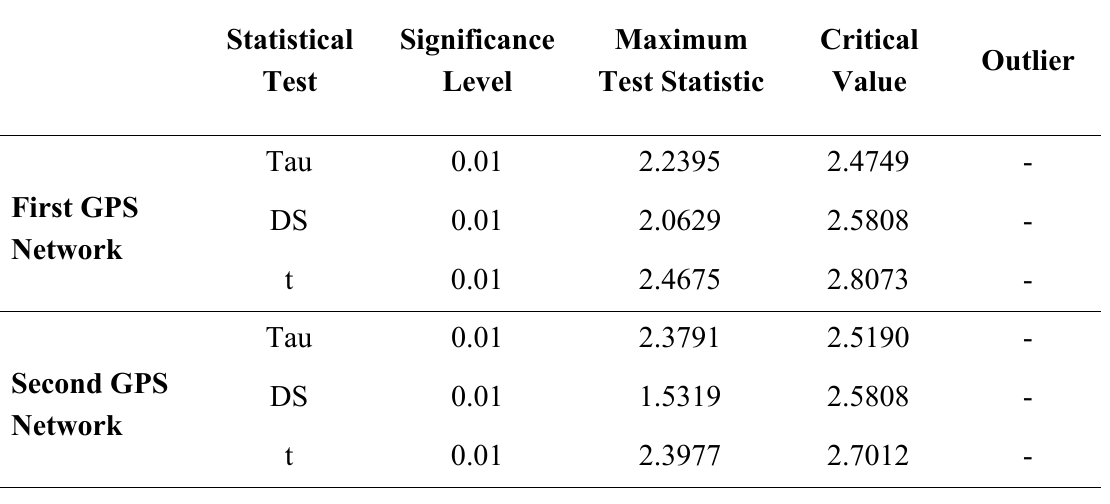
Table 4. Results of the conventional methods for the first and second GPS